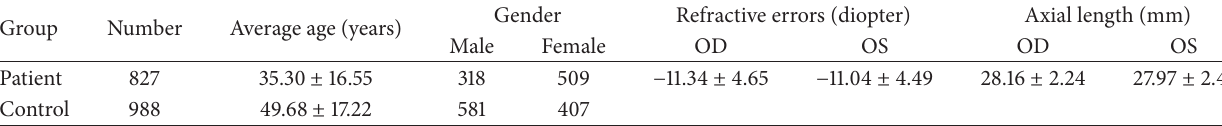
Table 1: Demographic and clinical characteristics of HM patients and controls in this